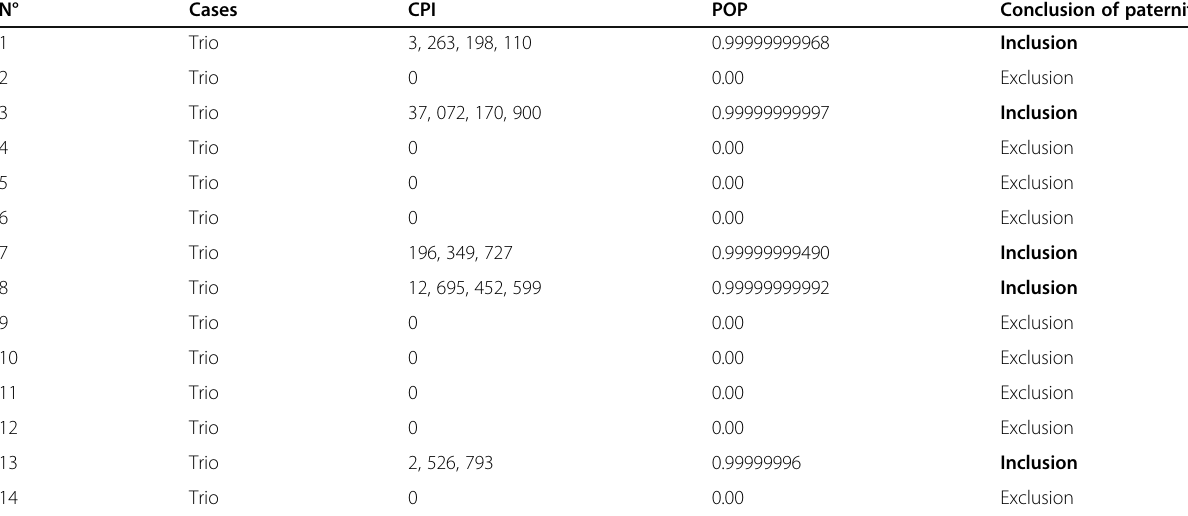
Table 3 Results of the combined paternity index (CPI) and the probability of paternity (POP) in trio cases N°